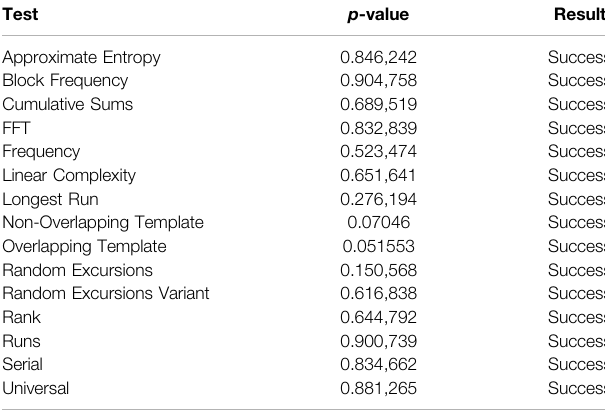
TABLE 3 | Results of SP 800 – 22 test using x 1 after decorrelation operation.